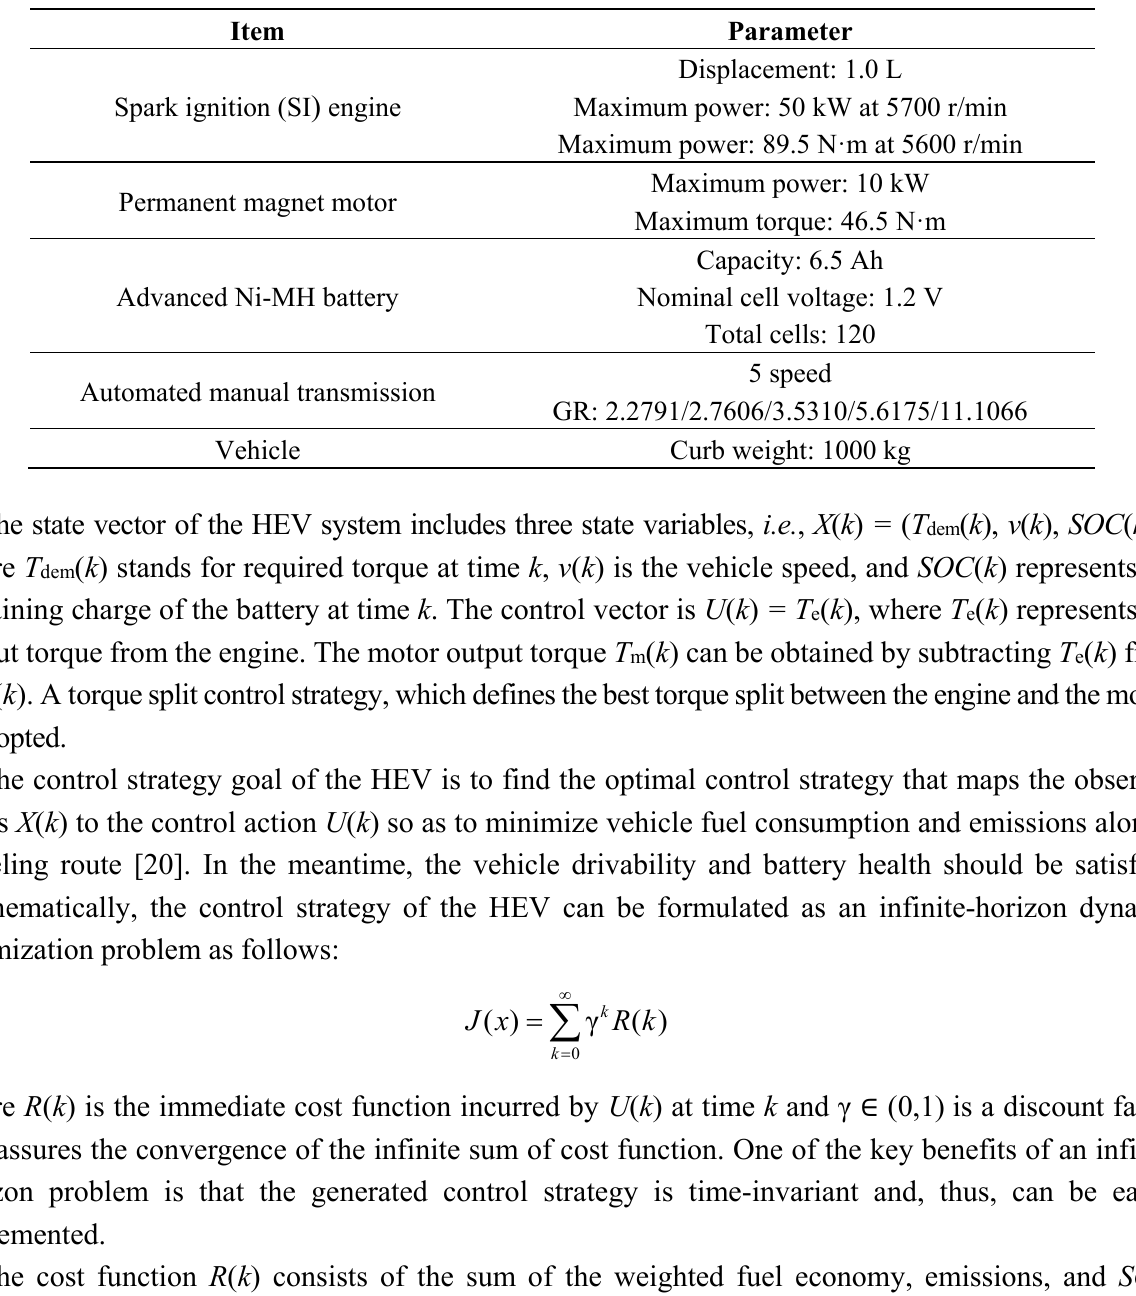
Table 1. Summary of the hybrid electric vehicle (HEV)